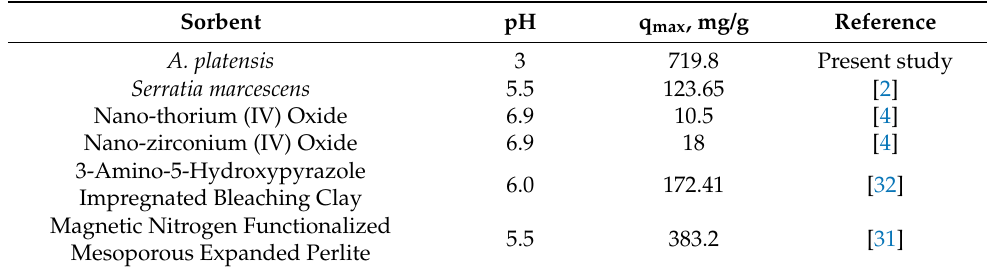
Table 2. Comparison of maximum sorption capacity for Y(III) achieved in the present study with the literature data.